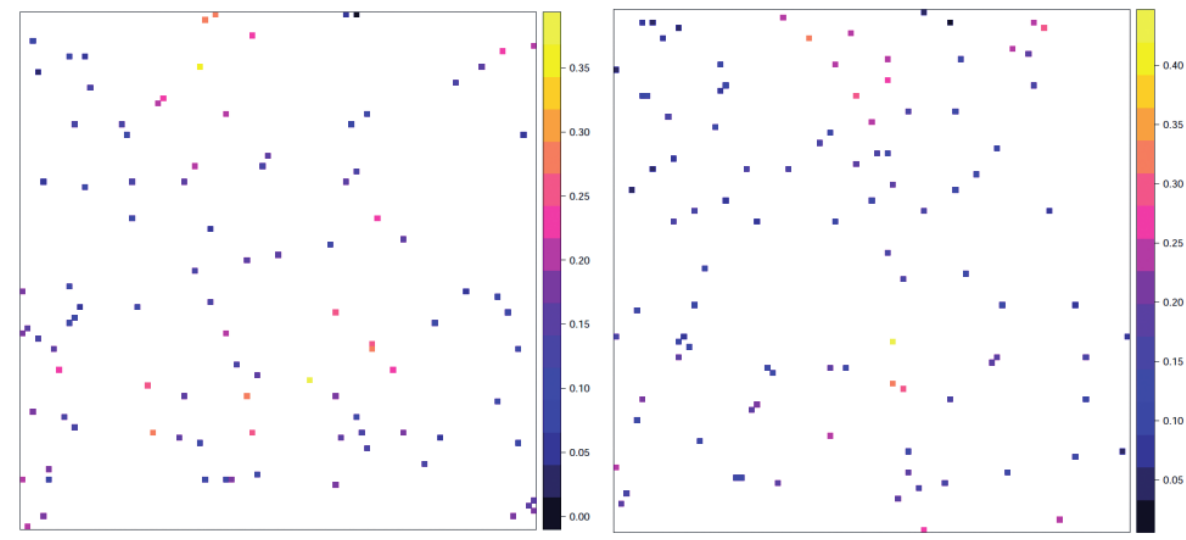
Figure 5. Two spatial samples drawn according to the two different methodologies: PPS (left) based on focus maps, and SRS (right). The lo- cation of points selected in the samples are colored according to the value assumed by the underlying target distribution (simplified risk, as- sumed as unknown). The two samples appear similar, but have been generated by two very different